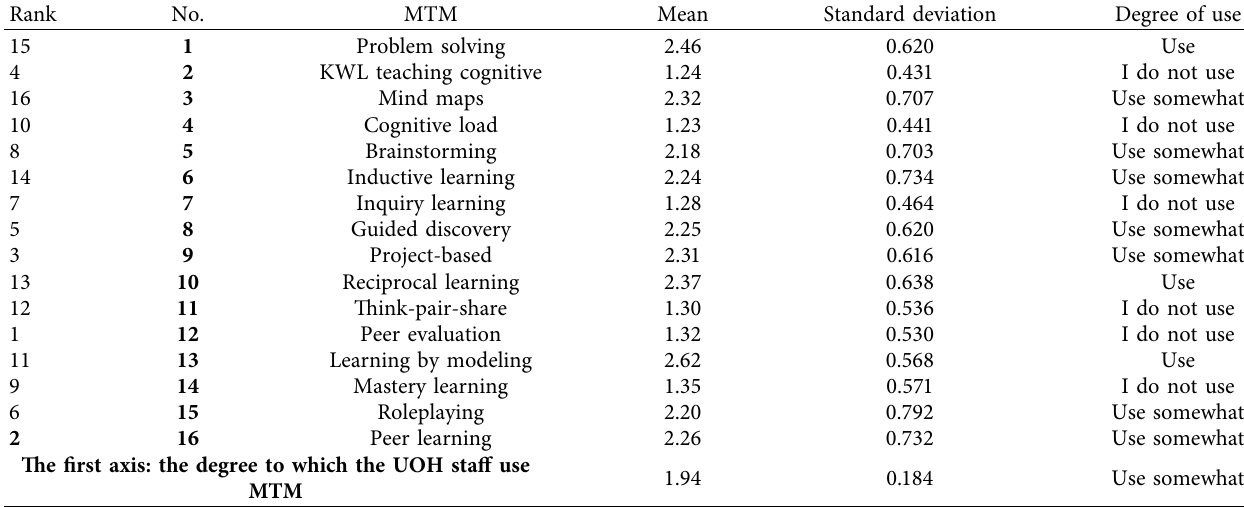
Table 5: Means and standard deviations for the questionnaire in the first axis: the degree to which UOH staff use MTM. Rank No.